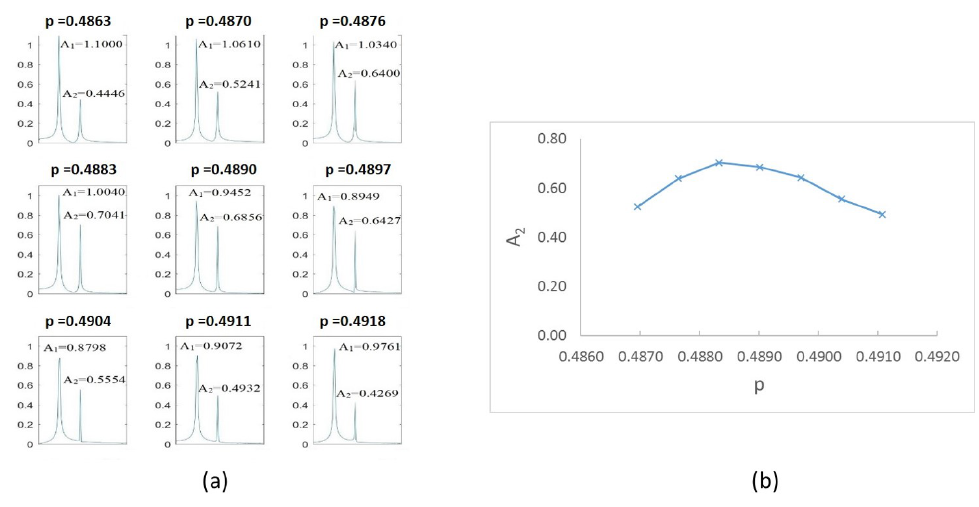
Ω c and ( b ) amplitude A 2 versus rotation speed for 2